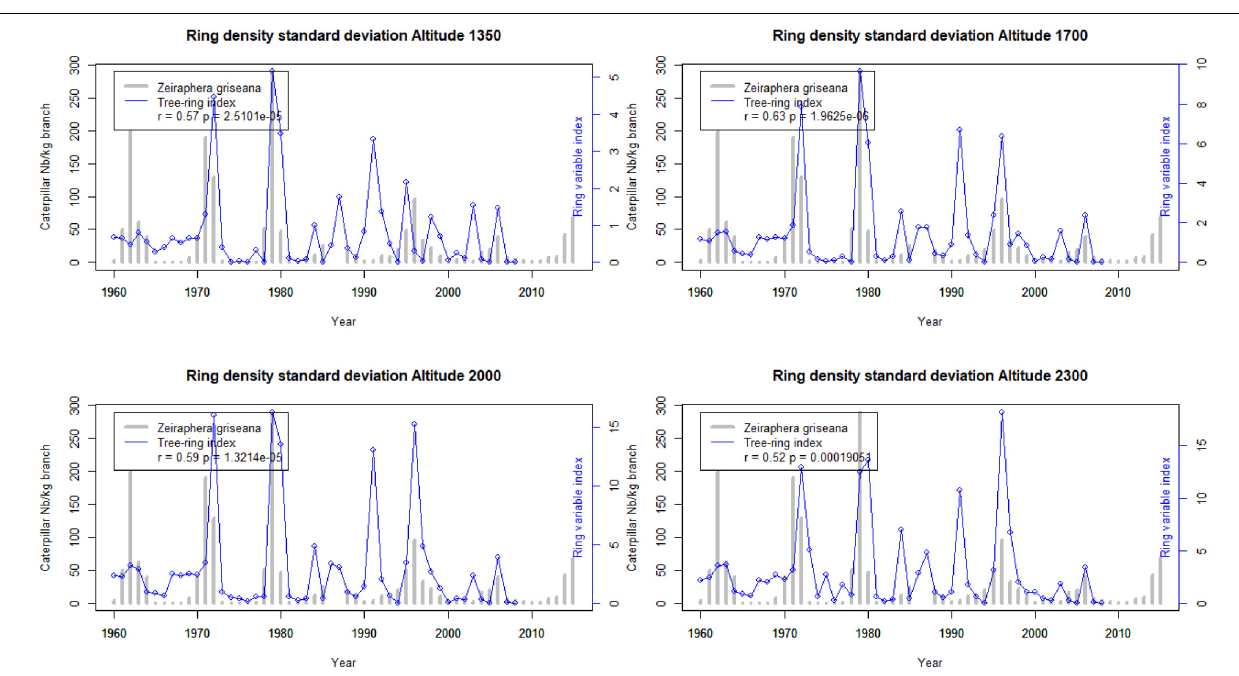
FIGURE 7 | Ring density standard deviation outbreak index at four elevations along the elevational gradient from 1960 to 2007 and the Les Combes outbreaks. Reconstructed LBM outbreaks (blue lines) and direct observations at Les Combes (gray